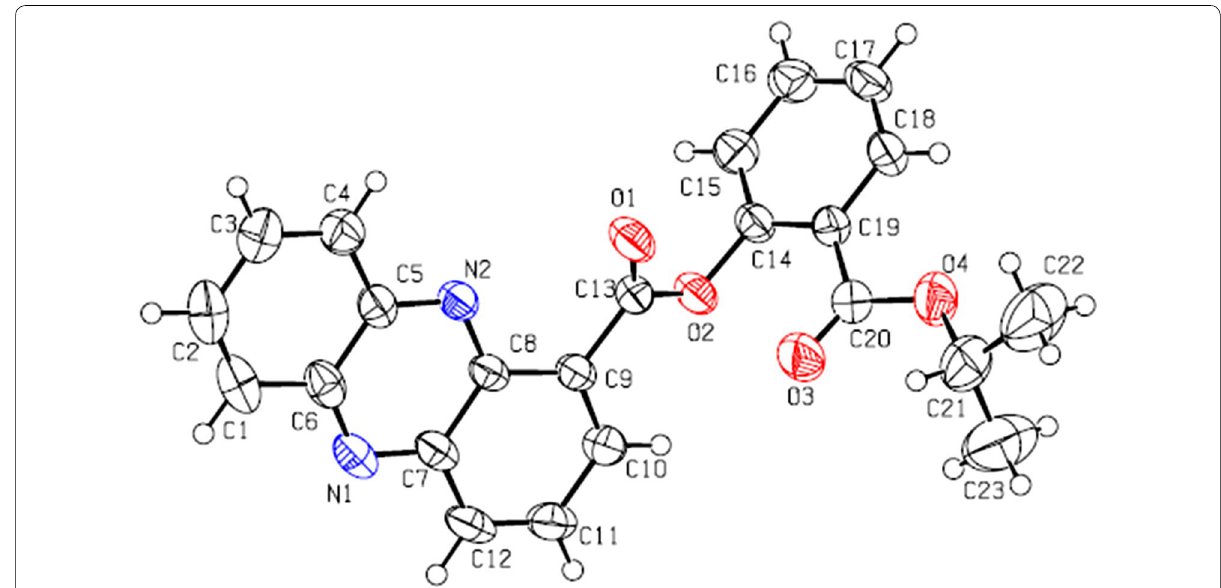
Fig. 4 The crystal structure of conjugate